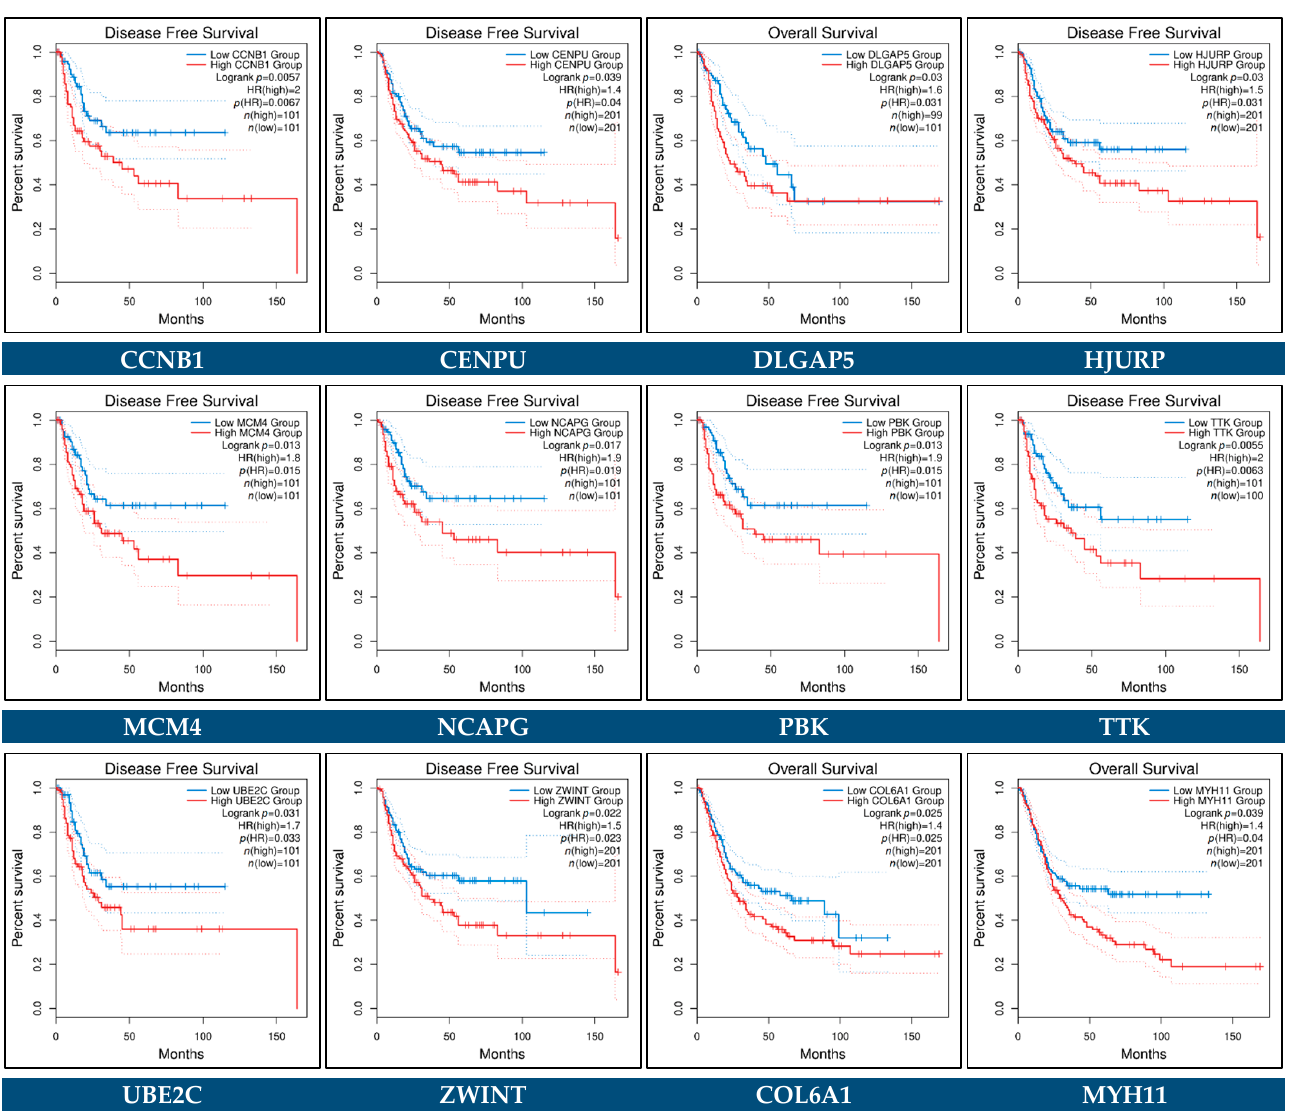
Figure 18. Kaplan–Meier survival plots of key hub genes, generated using the GEPIA2 platform. Red and blue lines indicate the high- and low-risk patient groups, respectively. Patients were grouped according to median or quartile cut-off values.